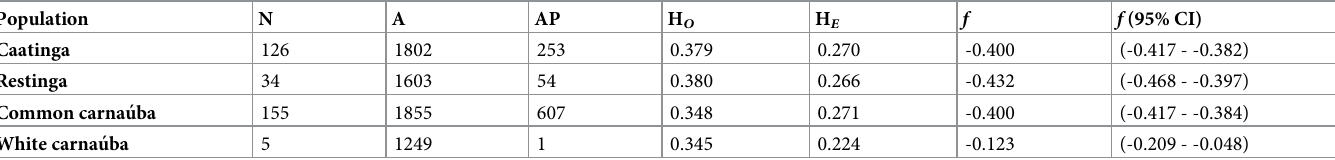
Number of individuals (N); total number of alleles (A); number of private alleles (Ap); observed heterozygosity (H O ); expected heterozygosity (H E ); inbreeding coefficient ( f ); f (CI of 95%) = lower and upper confidence interval of 95% of the inbreeding